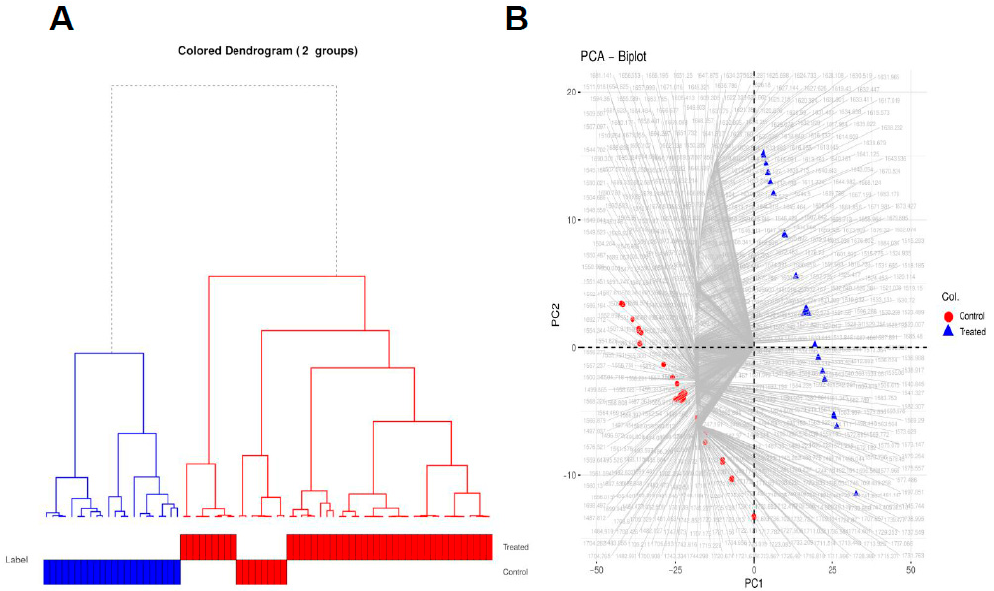
Figure 5. Hierarchical clustering of the spectral data of the samples. Hierarchical clustering of the spectra for the different experimental samples ( A ) and PCA biplot explaining which wavenumbers are associated with untreated versus treated samples ( B ).